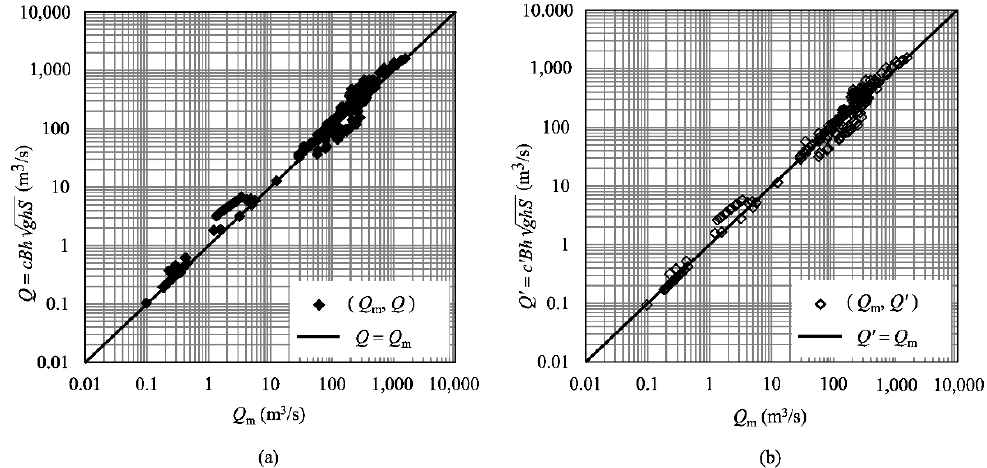
Figure 10. Comparison of the computed discharge ( a ) Q and ( b ) Q ′ with the measured discharge Q m .